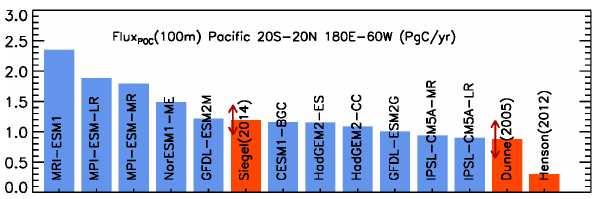
Figure 5. Total particulate organic carbon (POC) flux (Pg/year) at the depth of 100m in the eastern tropical Pacific (20 ◦ S to 20 ◦ N latitude and 180 ◦ E to 60 ◦ W longitude) estimated by each of the CMIP5 models (blue) and derived from measurements (orange) by Dunne et al. (2005), Henson et al. (2012), and Siegel et al. (2014). Results are ordered according to the flux magnitude. Dunne et al. (2005) reported errors of 35% and Siegel et al. (2014) errors of 20% (shown as